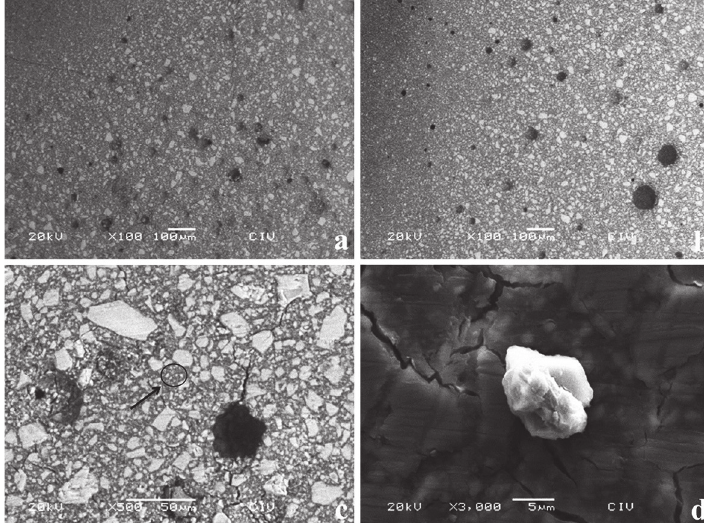
, and (c) FX-II 5% (w/w) TiO . Samples 2 2 nanopowder. 2